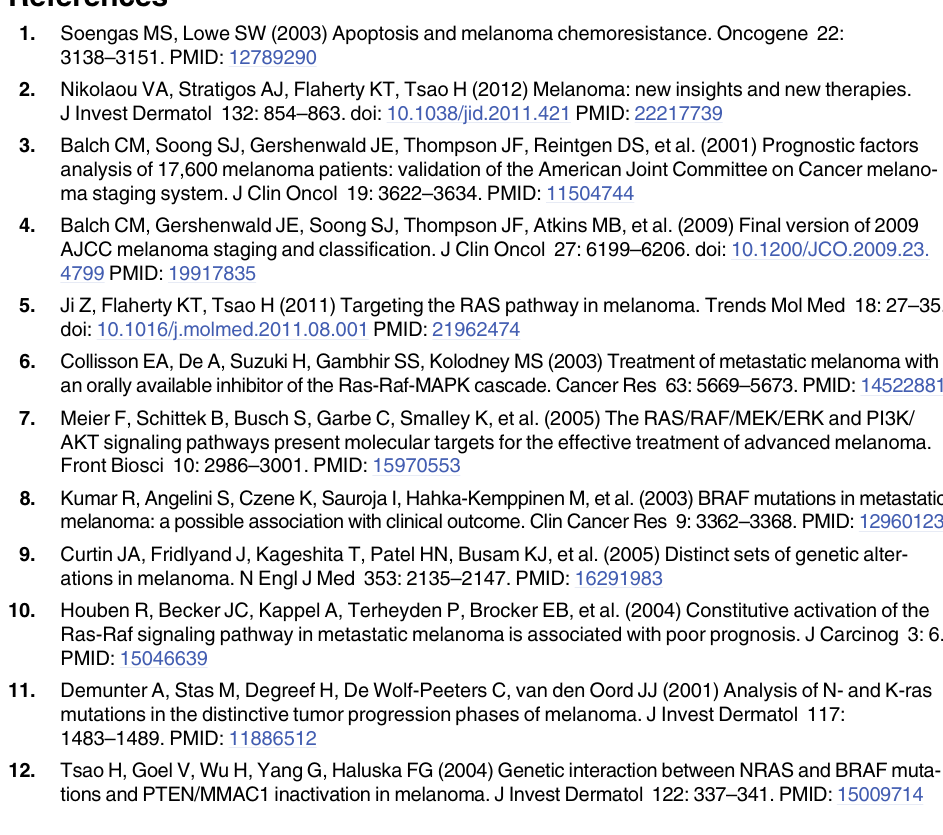
S3 Fig. Cell viability in NRAS mutant melanoma cells (M2met and VM-15) after combina- tion treatments. Effects of combined treatment with ZA and DTIC ( A, B ) or cisplatin ( C, D ) were investigated using 48hs treatment and SRB assay. Although some additive effect, no clear synergism could be observed. (TIF) S4 Fig. Migration in melanoma cells after combined treatment with zoledronic acid (ZA) and DTIC. ZA treatment increased the migratory activity of BRAF mutant cells, but interest- ingly, DTIC had no effect on ZA induced changes in cell migration. In NRAS mutant and dou- ble wild-type cells neither the single nor the combined treatment changed migration activity. Data shown as average ± SD are results of three independent measurements. Asterisks indicate significance of p < 0.05 by Kruskal-Wallis and Dunn ’ s multiple comparison test.